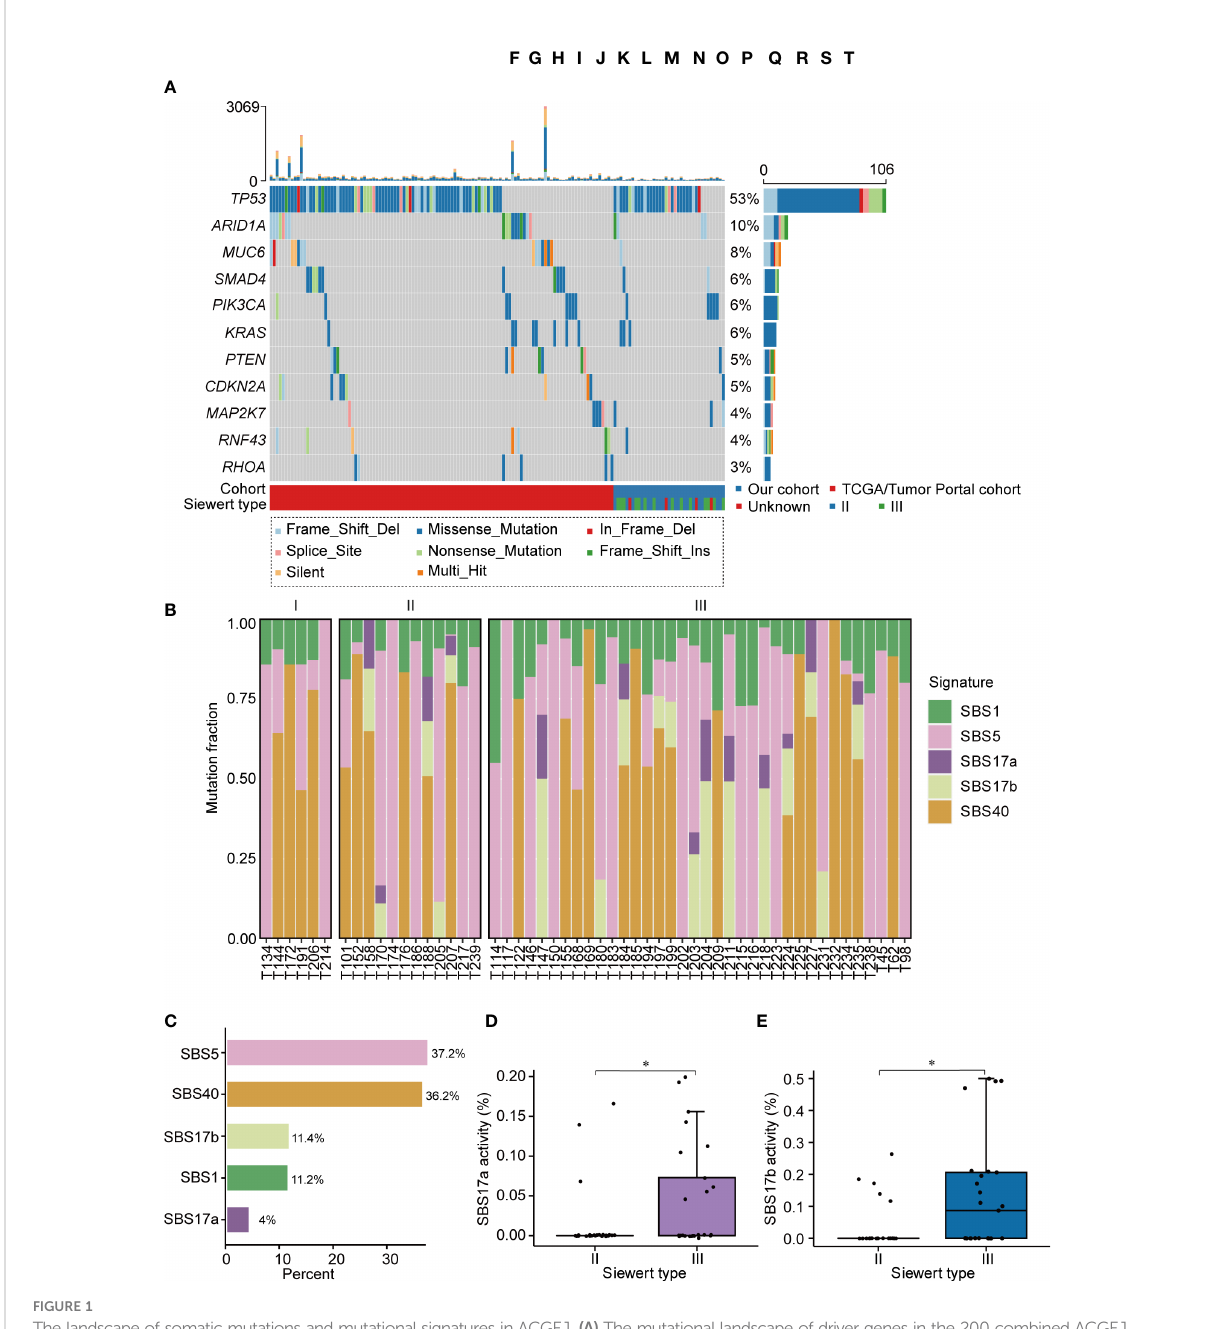
FIGURE 1 The landscape of somatic mutations and mutational signatures in ACGEJ. (A) The mutational landscape of driver genes in the 200 combined ACGEJ samples. Each column represents the tumor genome of one patient, and each row represents a gene. The top histogram shows the number of SNVs and indels in each patient. The histogram on the right displays the number of SNVs and indels in each gene. Driver genes (dNdScv, FDR q < 0.1) are ordered by the fraction of mutated tumor samples. (B) Bar plots showing the de fi ned mutational signatures in our ACGEJ samples. Samples are ordered by TNM stage. (C) Bar plots comparing the de fi ned mutational signatures and their relative contributions to somatic mutations. (D, E) SBS17a activity (D) and SBS17b activity (E) in different ACGEJ Siewert types. P values were derived from Wilcoxon rank-sum tests. Statistical signi fi cance was described as follows: *P <